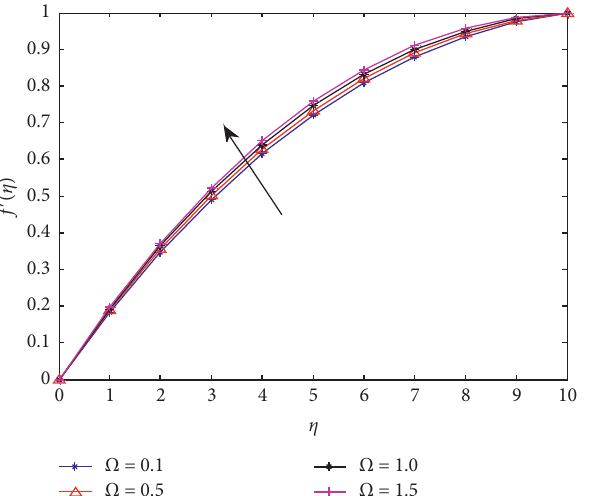
Figure 3: Velocity profile for various values of Ω when Pr � 0 . 72, M � λ � R � s � 1, β � 0 . 2, c � 0 . 2, and Ec � 0 . 1.